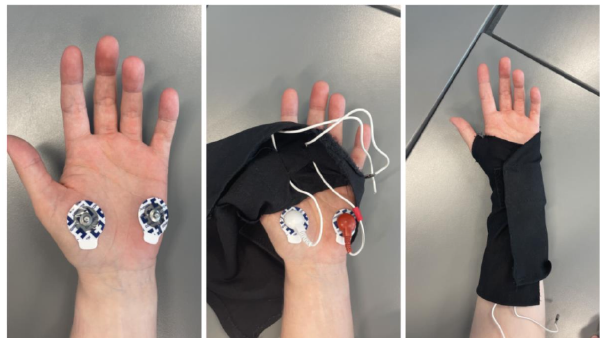
Figure 5: Photo of electrode placement and